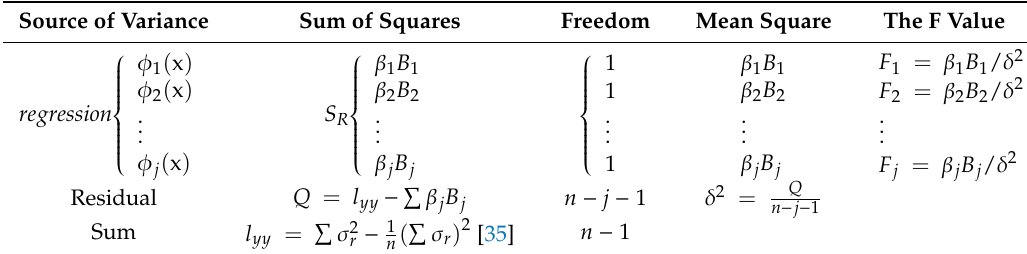
Table A1. Analysis of variance of orthogonal